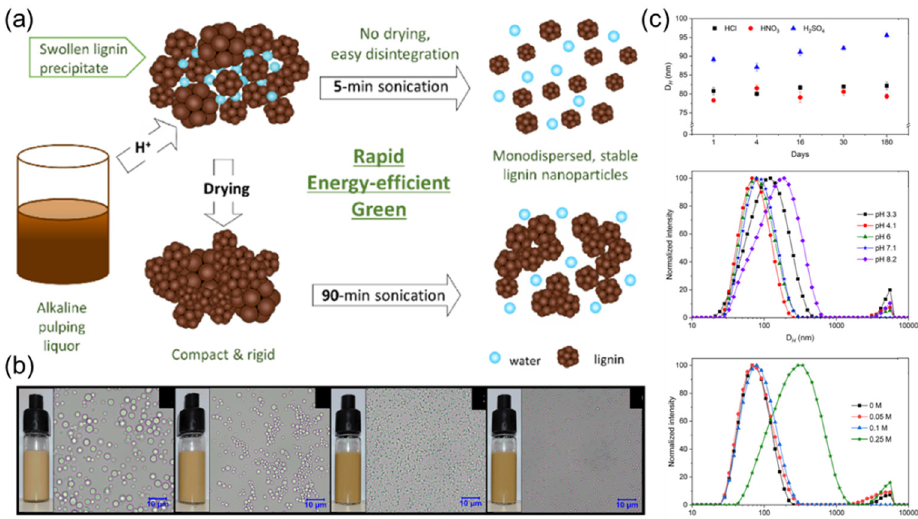
Figure 4. ( a ) A green and rapid method of preparing LNPs directly from a sulfur-free alkaline pulping liquor by combining acid precipitation and ultrasonication; ( b ) the optical images of LNPs with various hydrochloric acid; ( c ) stability of the LNPs monitored by the changes in the average hydrodynamic diameter. Reprinted with permission from Ref. [23]. Copyright 2019 American Chemical Society.